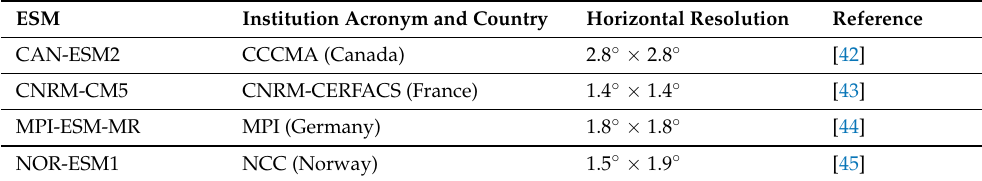
Table 4. The four CMIP5 Earth System Models (ESMs) used in this